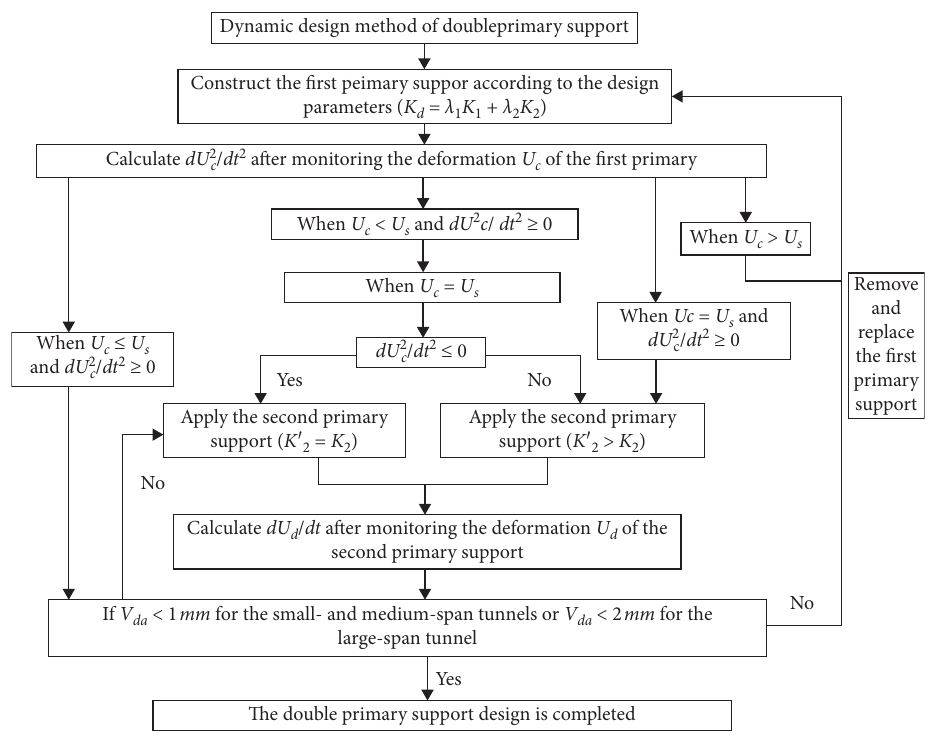
Figure 3: Dynamic design method of double primary